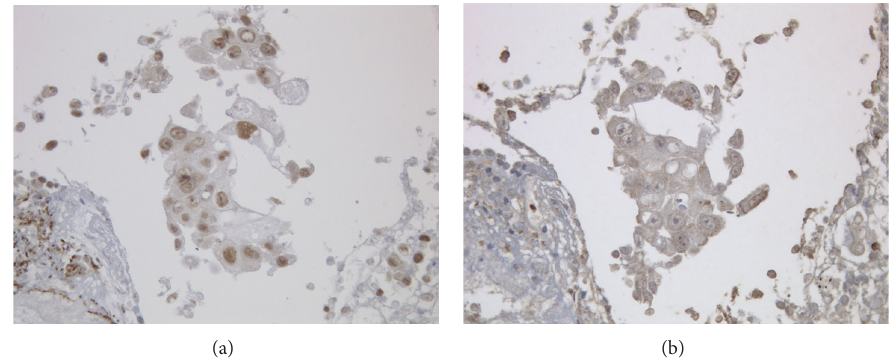
staining. (a) Immunohistochemical examination with an anti-interluekin-6 antibody revealing cytoplasmic and nuclear membrane staining